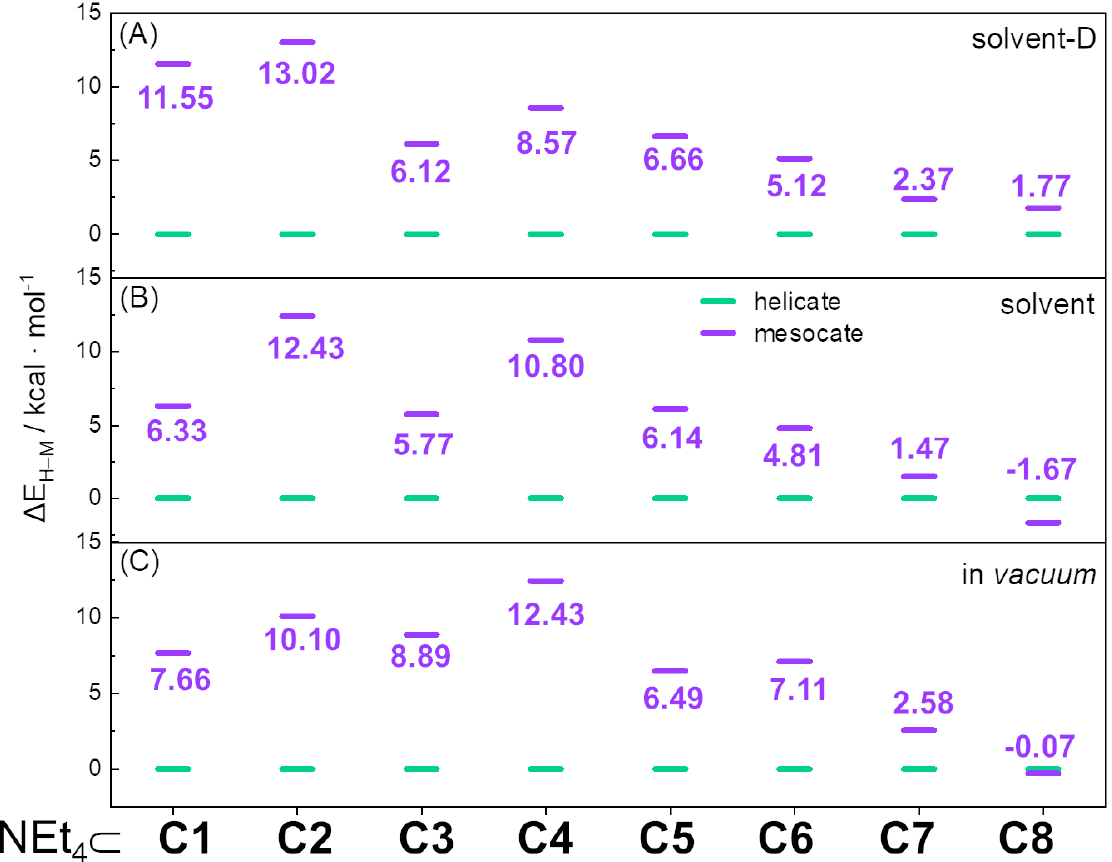
Figure 4. Energy differences ∆ E H–M (kcal/mol) between helicate (green) and mesocate (violet) isomers for in-solvent-D ( A ), in-solvent ( B ), and in vacuum ( C ) calculations. The energy of the helicate is considered 0.